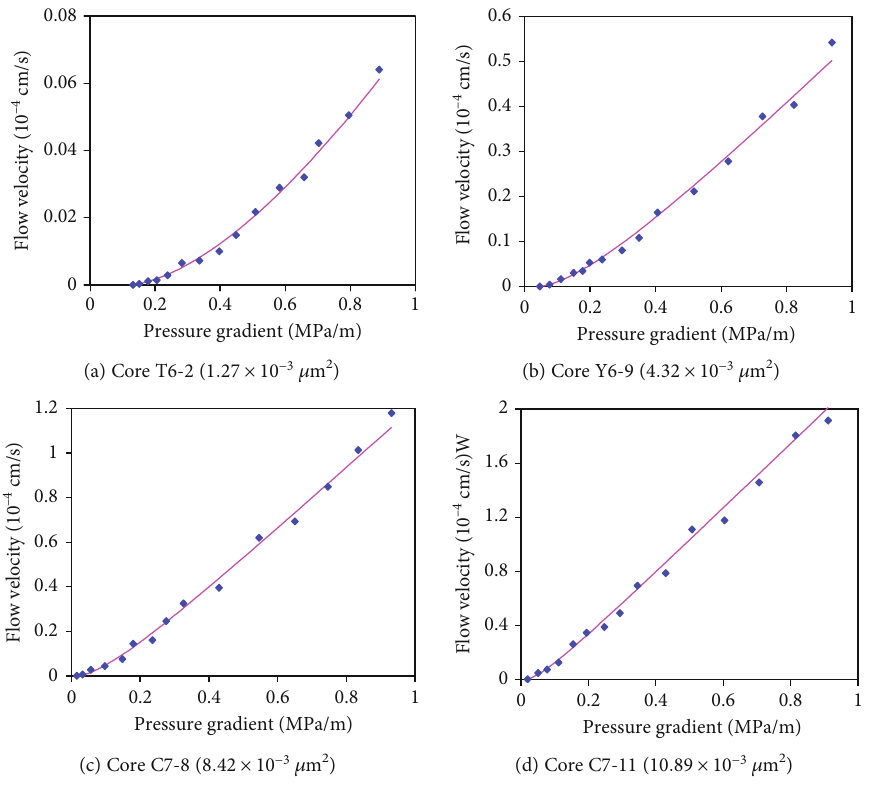
Figure 7: Nonlinear fl ow curve of di ff erent low-permeability cores.